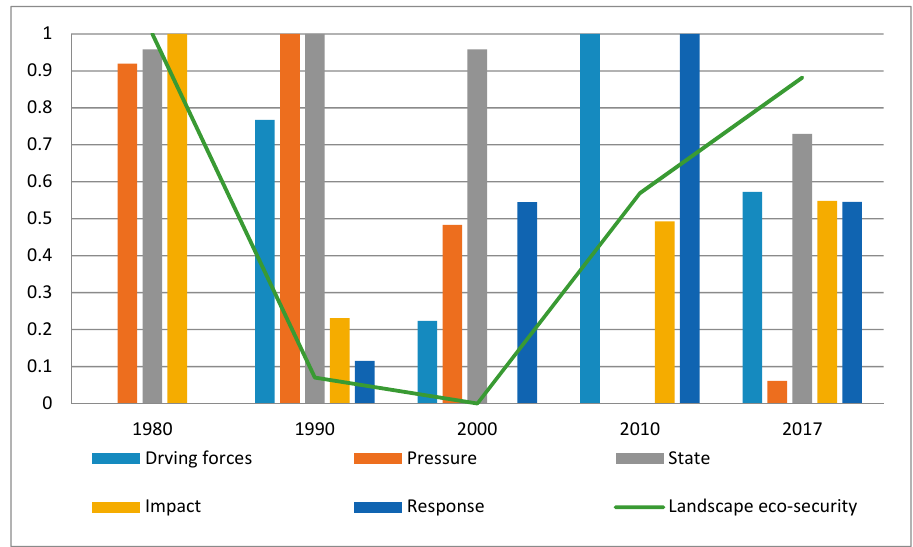
Figure 6. Changing trend of the landscape eco-security index in the study area.